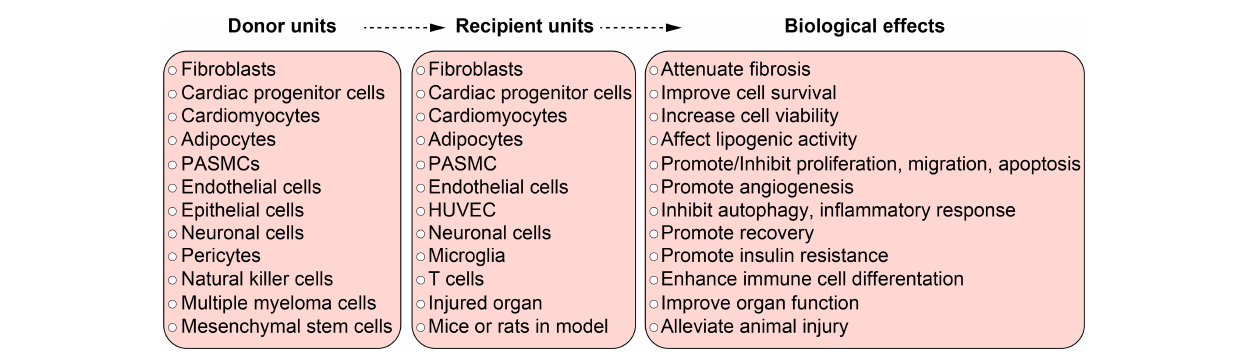
FIGURE 3 | The function of hypoxic exosomes in non-malignant diseases. A summary of donor units, recipient units, and biological effects in different systems. Each box brie fl y summarizes the corresponding contents from different systems, they don ’ t relate to each other line to line. Speci fi c relationship among the donor units, recipient units, and biological effects can be found in Table 1 and in the